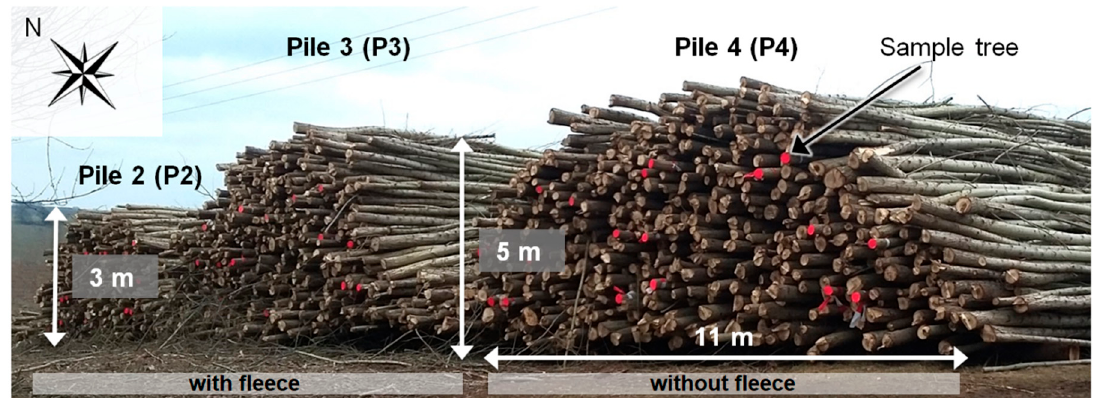
Figure 5. Structure of piles of whole poplar trees in trial P2 – P4 in Schwarzbach.